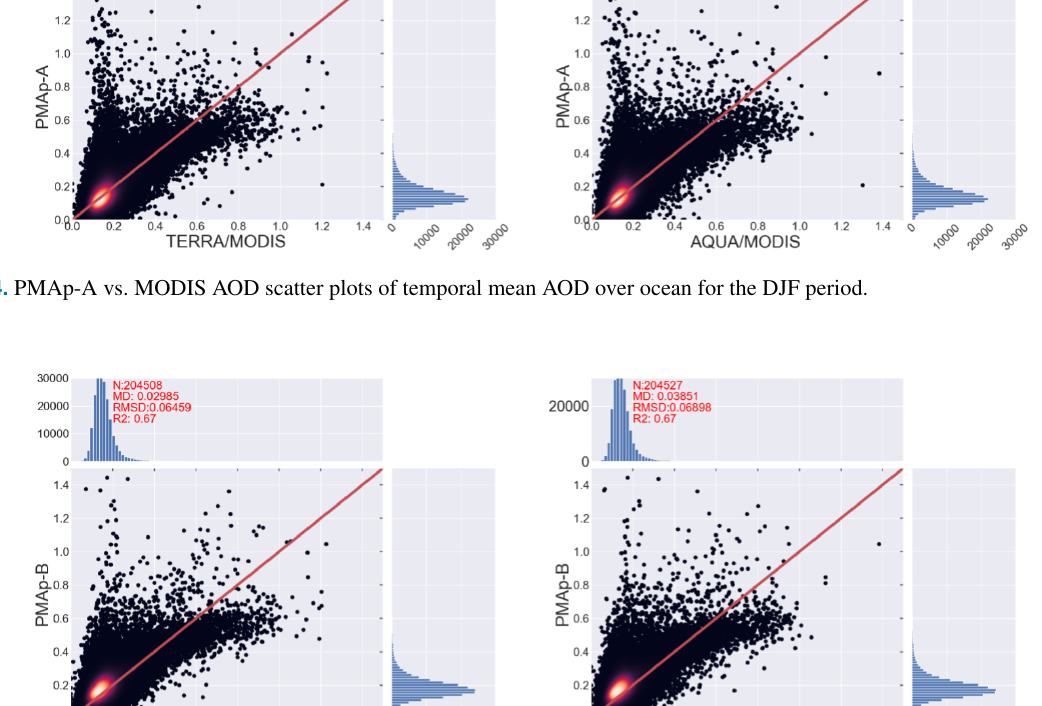
https://doi.org/10.5194/acp-22-14657-2022 Atmos. Chem. Phys., 22, 14657–14692,